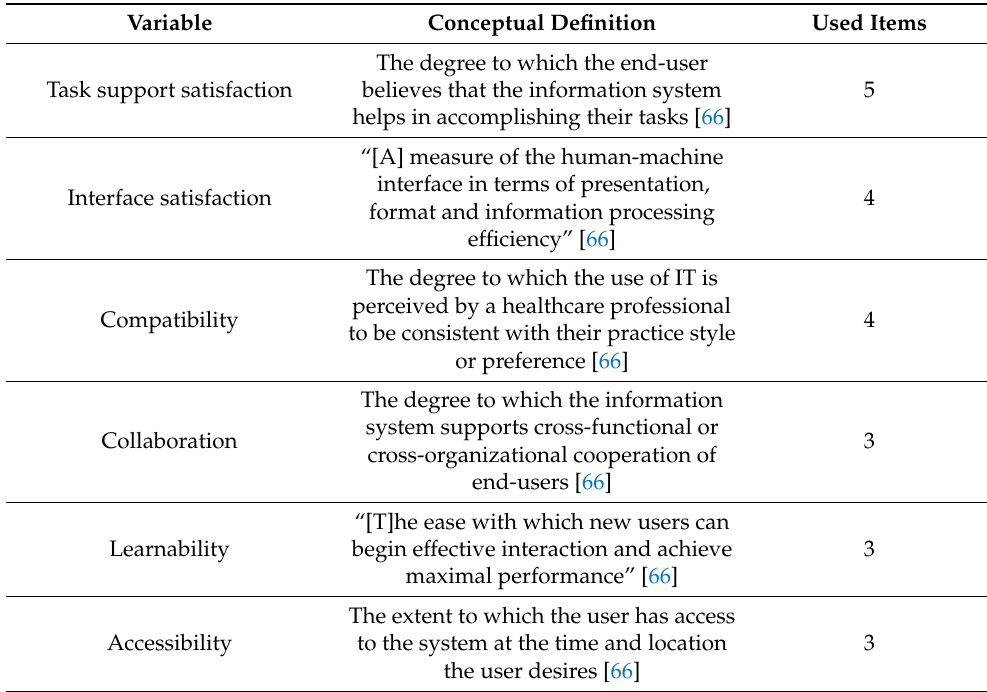
Table 3 defines variables related to HIS components that influence patient identifica- tion, along with their conceptual and operational definitions. Table 3. HIS